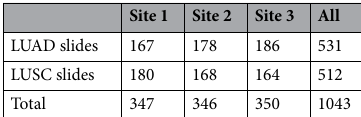
Table 2. Data split of